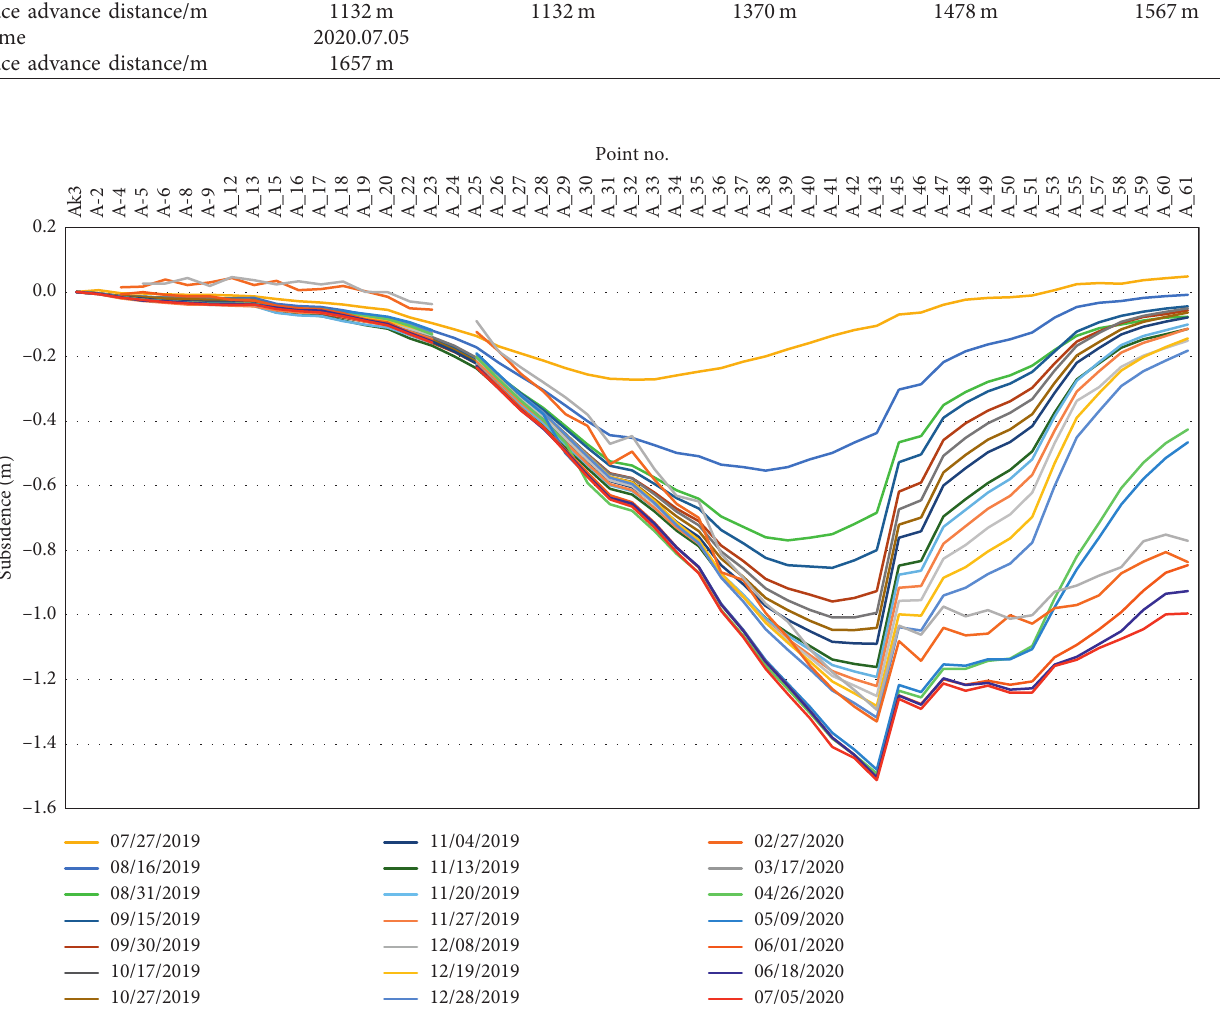
Figure 9: Profile of monitoring Line A along strike of 31103